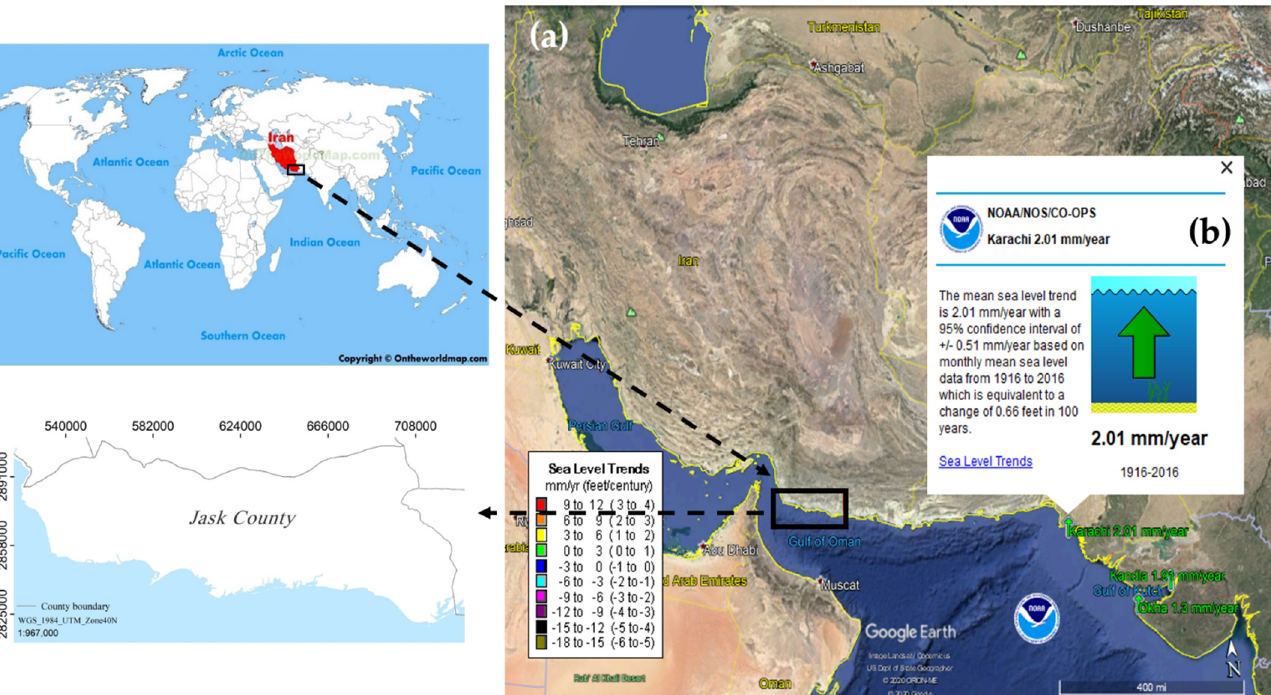
Figure 1. ( a ) Study area location shown on Google Earth satellite imagery with sea level trend. ( b ) The relative sea level trend (from the closest tide gauge) based on monthly mean sea level data from 1916 to 2016, from reference [63], is 2.01 mm/year which is equivalent to a change of 0.2 m in 100 years.